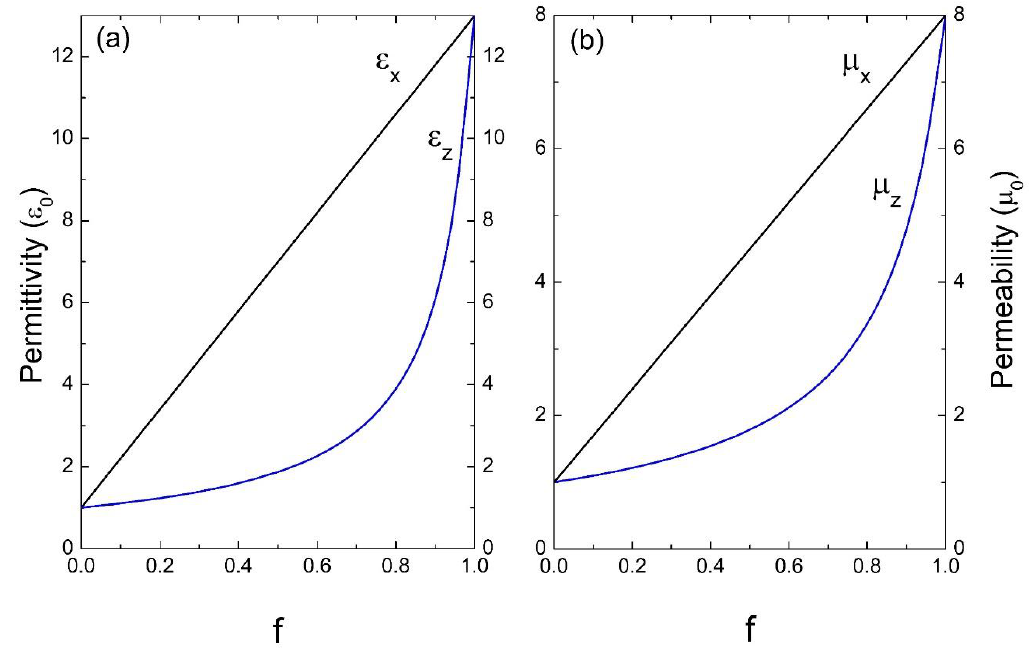
Figure 3. Permittivity ε ( a ) and permeability μ ( b ) versus the filling fraction f (ε 0 and μ 0 are the units).